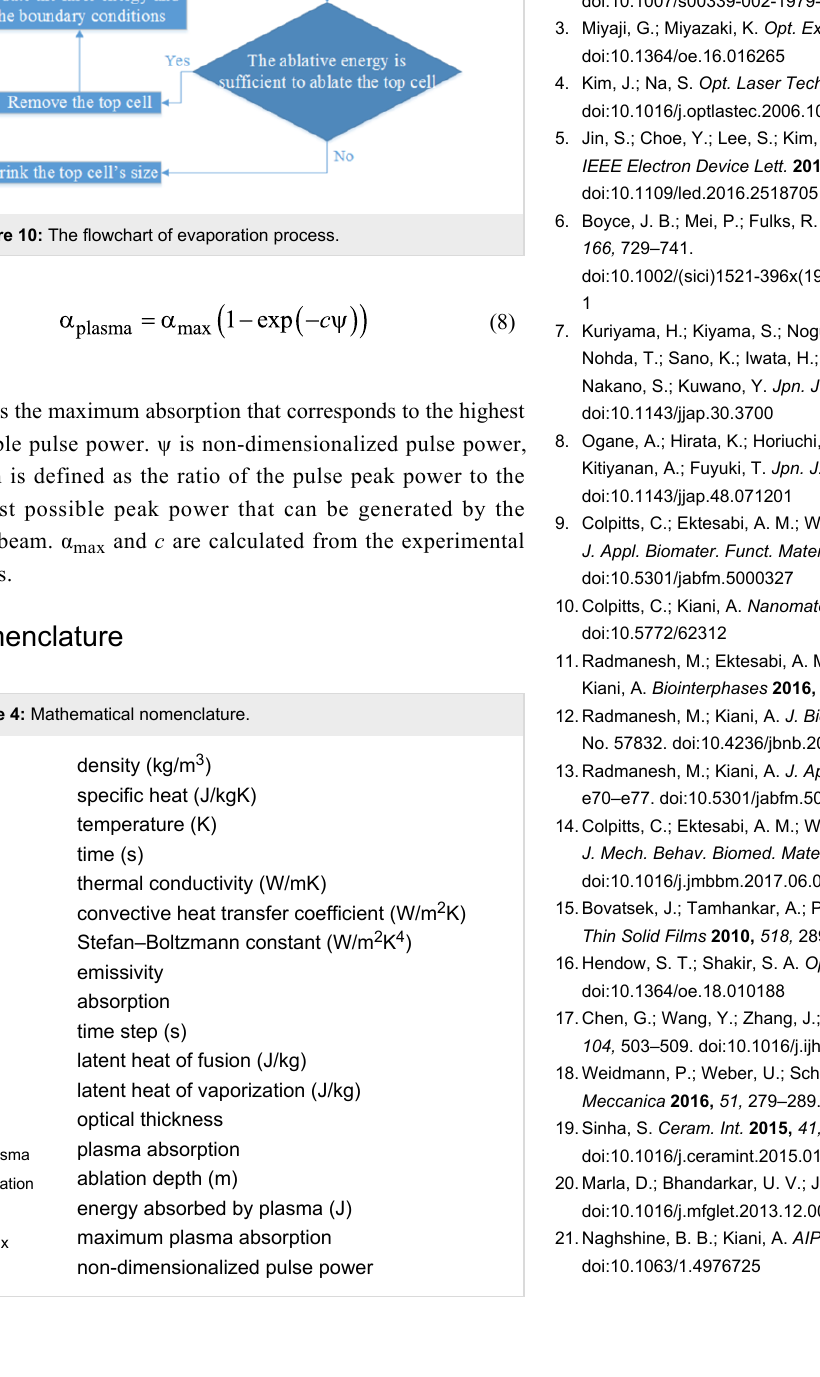
Figure 10: The flowchart of evaporation process.